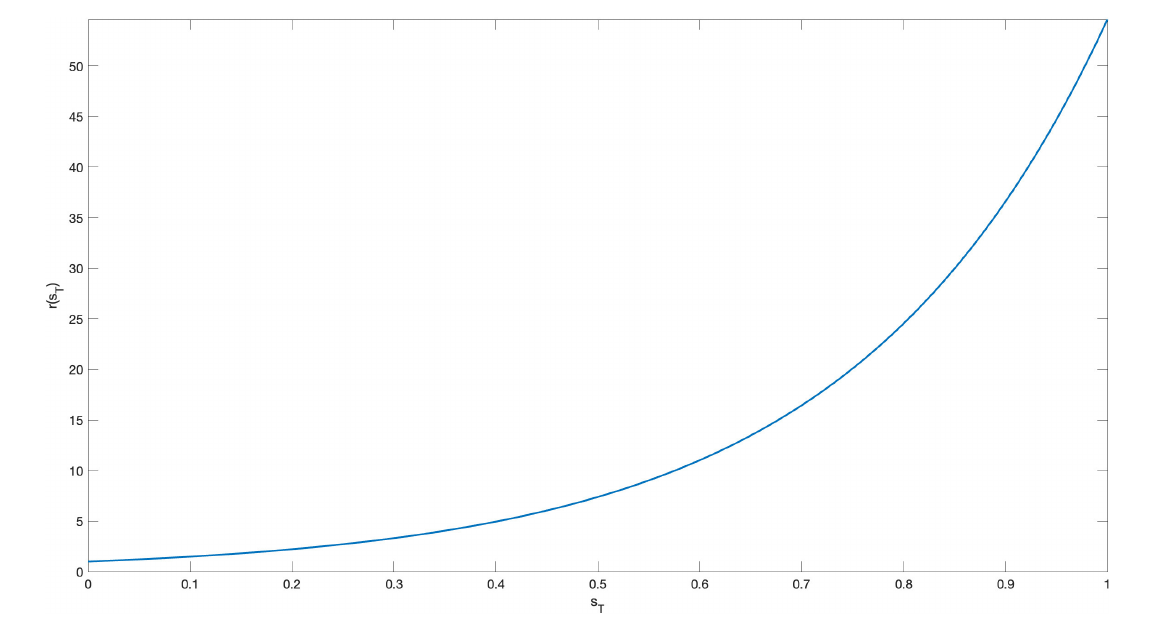
accounting for different attitudes of the DM—for example strongly penalizing the eventuality of decreasing